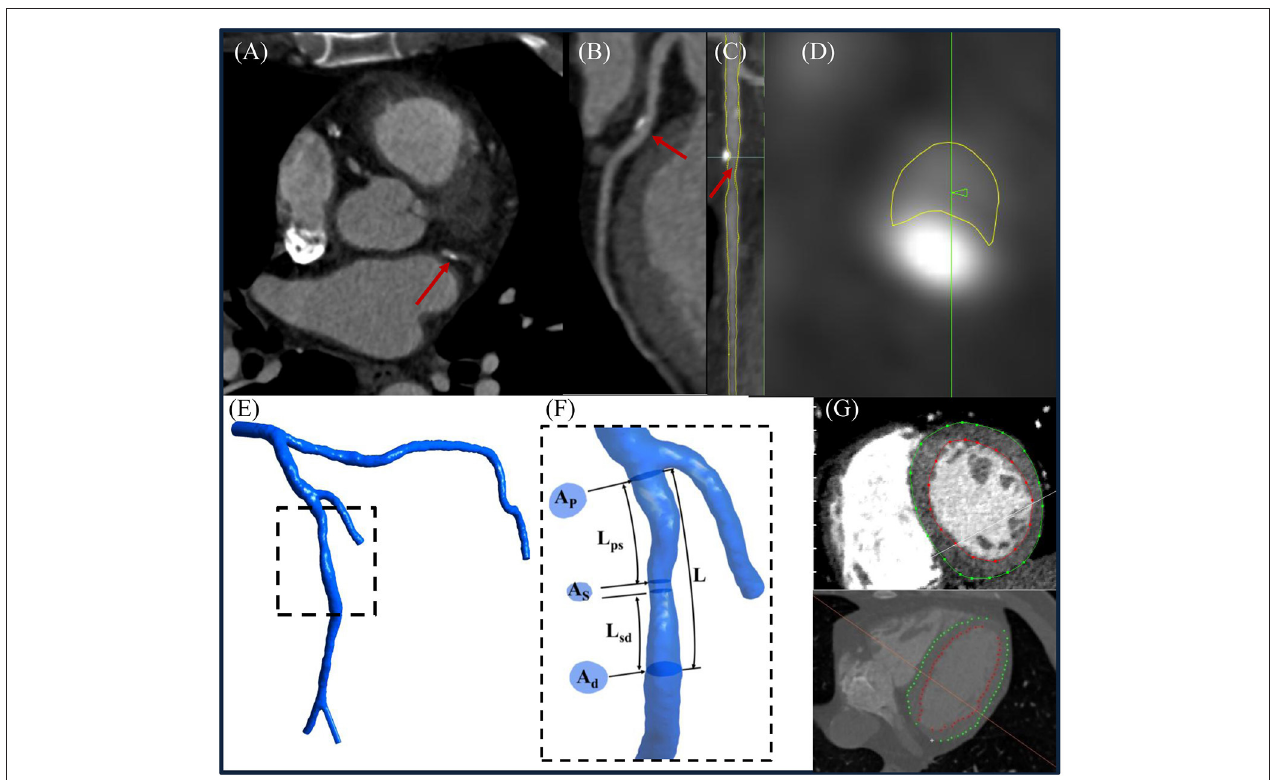
FIGURE 3 | (A) Representative computed tomography coronary angiography (CTCA) cross-sectional slice, (B) curved multiplanar reconstructed images of a left anterior descending (LAD) coronary artery, (C) straightened LAD with segmented lumen lines (yellow color) in transversal and (D) cross-sectional views, (E) reconstructed 3D left coronary tree, and (F) enlarged view to illustrate how to measure A p , A s , A d , L ps , L sd , and L from the model. (G) Left ventricular (LV) endocardial and epicardial contours were delineated from CTCA images to calculate the LV mass. (Note: A p , A s , and A d represented the lumen area at proximal, maximally stenosed, and distal segments, respectively; L ps , L sd , and L were the length measured from the proximal end of the coronary lesion to the proximal end of the maximally stenosed segment, the distal end of the maximally stenosed segment to the distal end of the coronary lesion, and the proximal to the distal ends of the whole coronary lesion, respectively. Flow entrance and exit angles ( α and β ) were then calculated using Eqs. (A-1) and (A-6) in the Supplementary Material ,